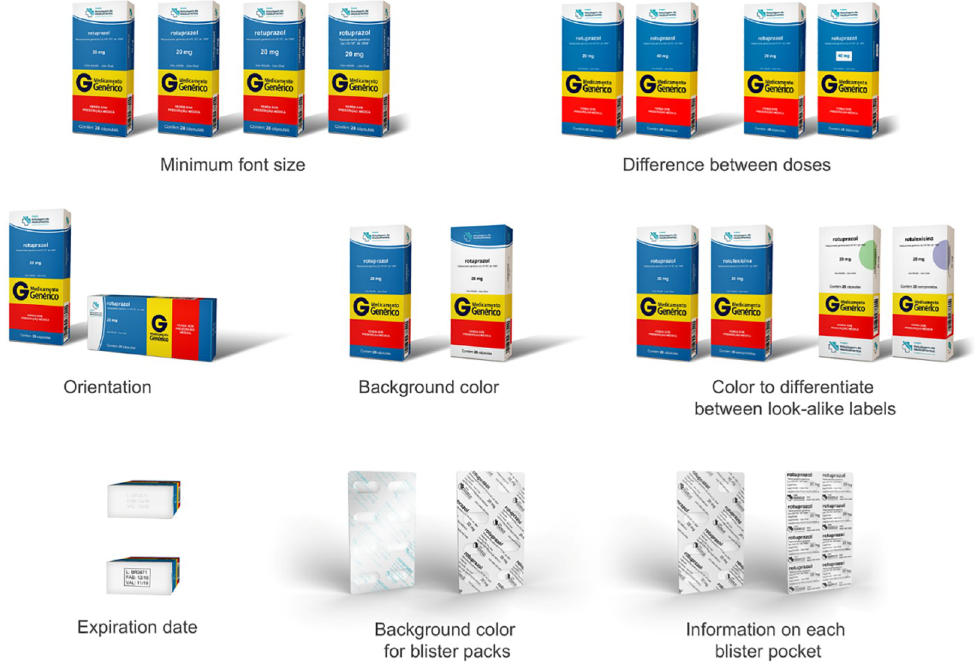
Fig 2. Simulated primary and secondary medication packages presented to